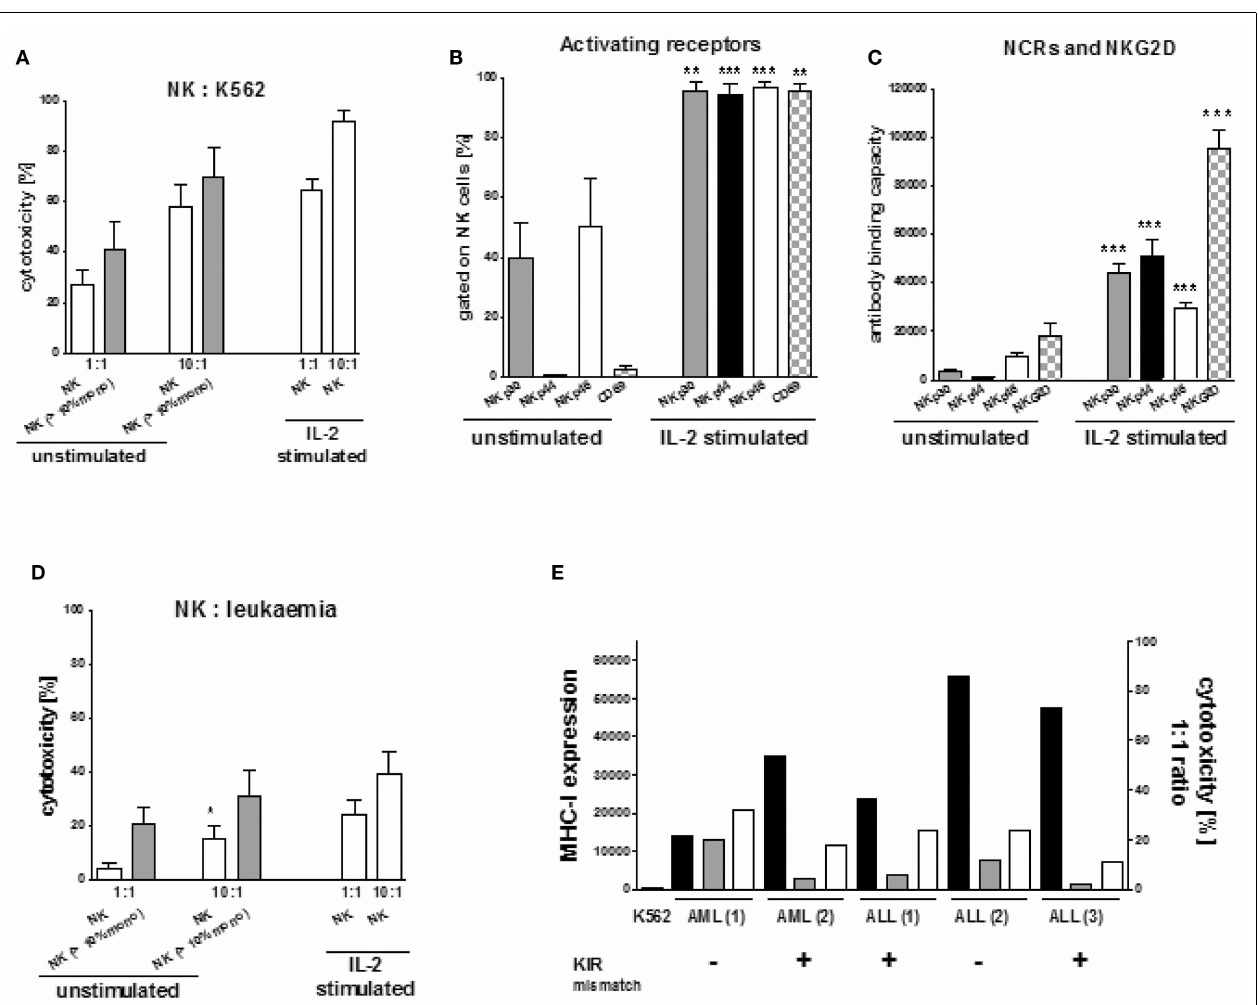
FIGURE 5 | Cytotoxicity of NK cells against K562 and patients’ leukemic cells. (A) Donor NK cell cytotoxicity against K562 cells was significantly increased after IL-2 stimulation compared to unstimulated NK cells and also seemed to be slightly increased for unstimulated NK cells if the purified NK cell products include > 10% concomitant monocytes. (B) IL-2 stimulation led to a significant increase in the percentage of NK cells with the natural cytotoxicity receptors NKp30, Nkp44, NKp46, and the activating receptor CD69. (C) In addition IL-2 stimulation led to a significant up-regulation of NKp30, NKp44, NKp46 on NK cells as well. (D) Concomitant monocytes ( > 10%) in the purified NK cell products increased donor NK cell